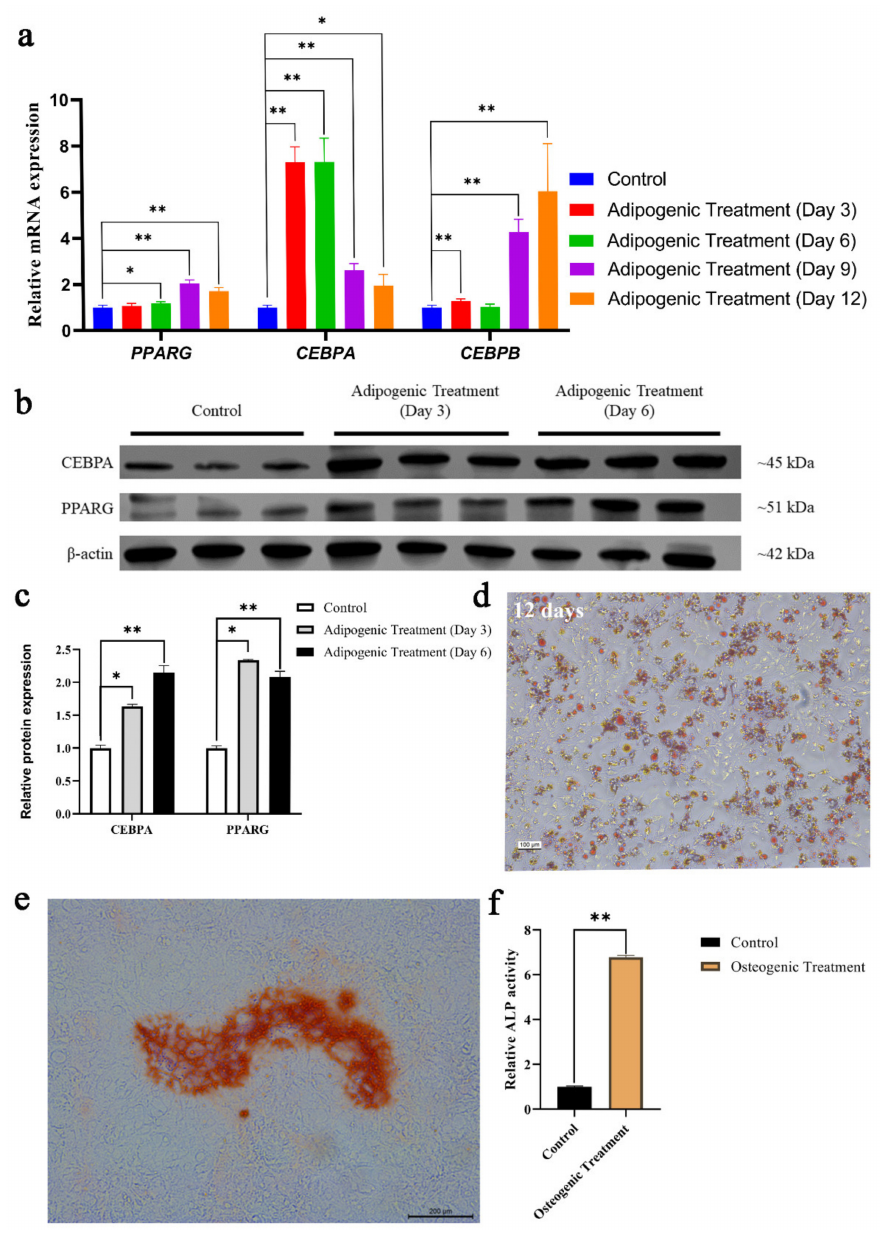
Figure 4. Induction of adipogenic and osteogenic differentiation of chicken BM-MSCs. ( a ) Adipogenic genes were detected using qRT-PCR after adipogenic treatment for 3 days, 6 days, 9 days, or 12 days. ( b ) Western blot was used to detect the adipogenic protein after adipogenic treatment for 3 days and 6 days. ( c ) Adipogenic protein expression assessed by Western blot analysis is expressed relative amount to β -actin. ( d ) Oil red O staining confirmed the adipogenic differentiation of BM-MSCs. ( e ) Alizarin Red Staining showed that mineralized bone nodules have formed under osteogenic treatment. ( f ) ALP activity increased significantly after osteogenic treatment compared with normal BM-MSCs. Symbol “*” and “**” indicate a significant difference at p < 0.05 and p < 0.01,